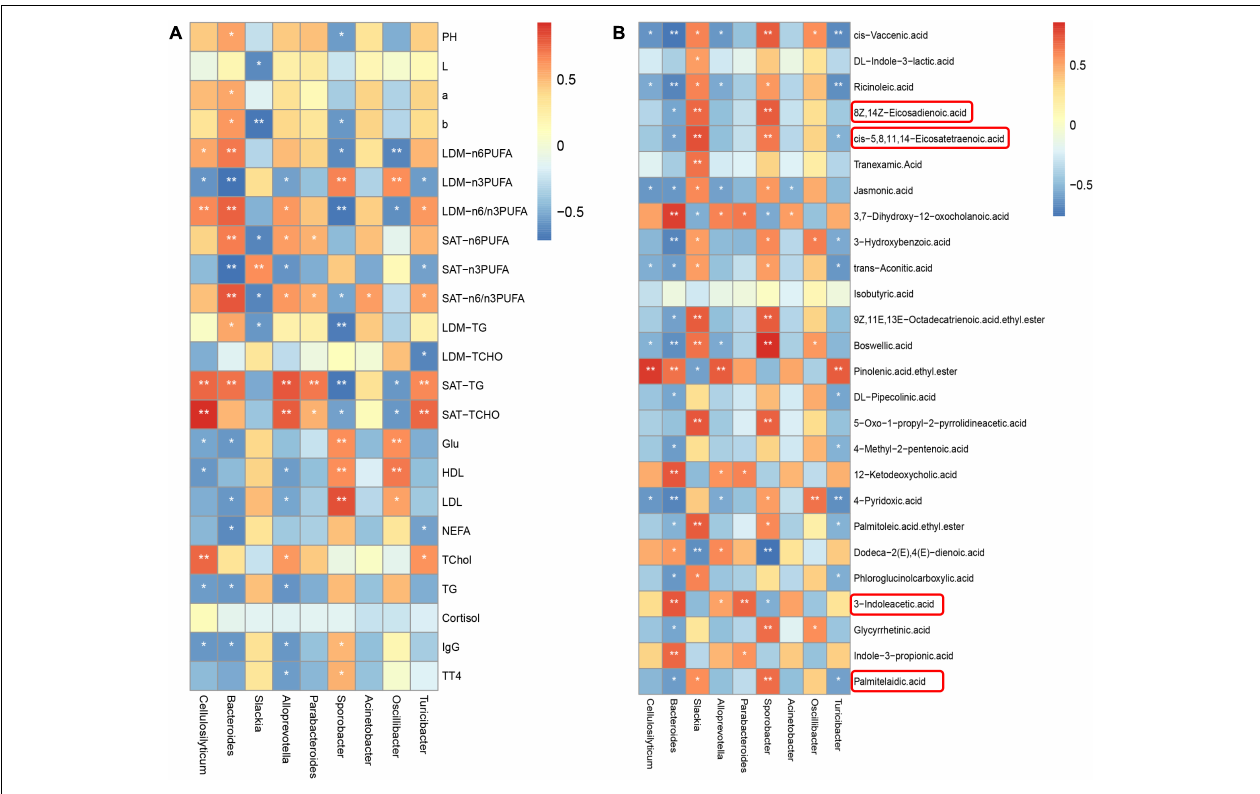
FIGURE 5 | Correlations among meat quality, fatty acid profiles, the biochemical indexes in serum, differential microbiota at the genus level and bacterial metabolites in colonic digesta of Heigai pigs. (A) Correlations between meat quality, fatty acid profiles, the biochemical indexes in serum with differential microbiota at the genus level of Heigai pigs. (B) Correlations between meat quality, fatty acid profiles, the biochemical indexes in serum with bacterial metabolites in colonic digesta of Heigai pigs. Each square represents a Pearson correlation coefficient between a genus and an index, while the gradation of color represents the size of each correlation coefficient. The red color represents a positive correlation, while the blue color represents a negative correlation. pH, pH 45 min–pH 24 h; L, L 24 h–L 45 min; a, a 24 h–a 45 min; b, b 24 h–b 45 min. * P < 0.05, ** P <